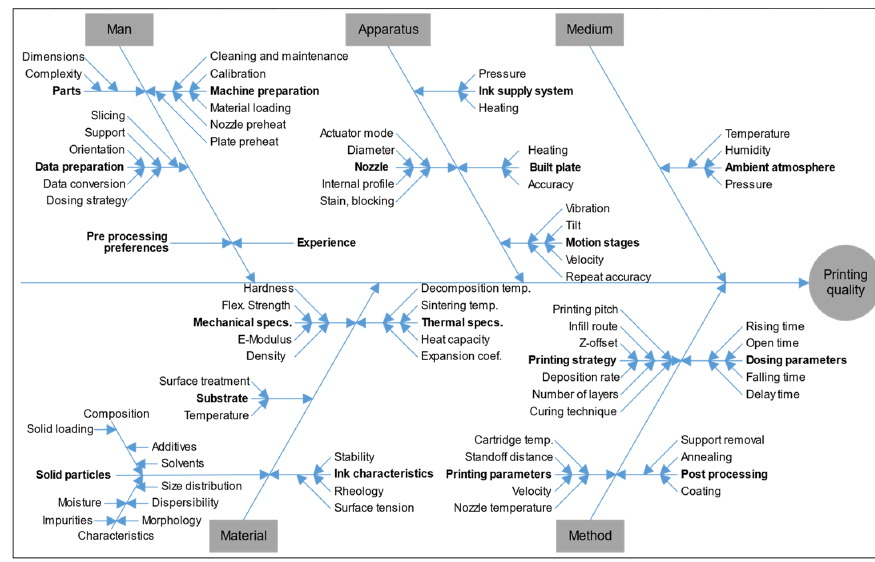
Figure 5. Various factors influencing the final quality of parts printed using MJ